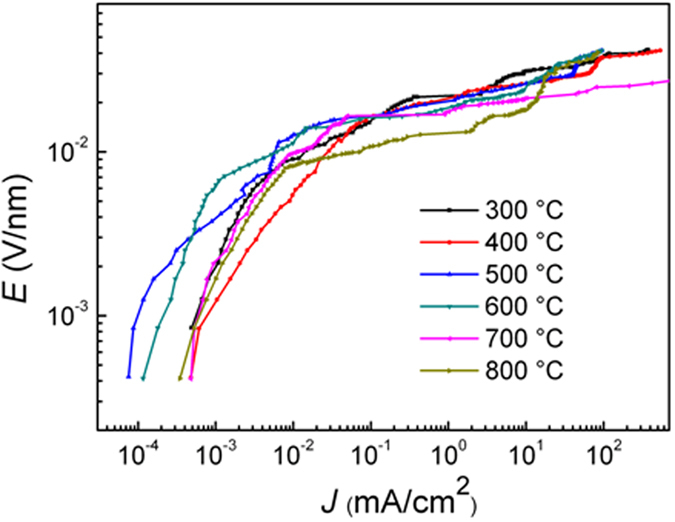
E-J characteristic curves of the varistors prepared by hot-dipping ZnO0.81 thin films in Pr6O11 for 50 min in air at different temperatures.